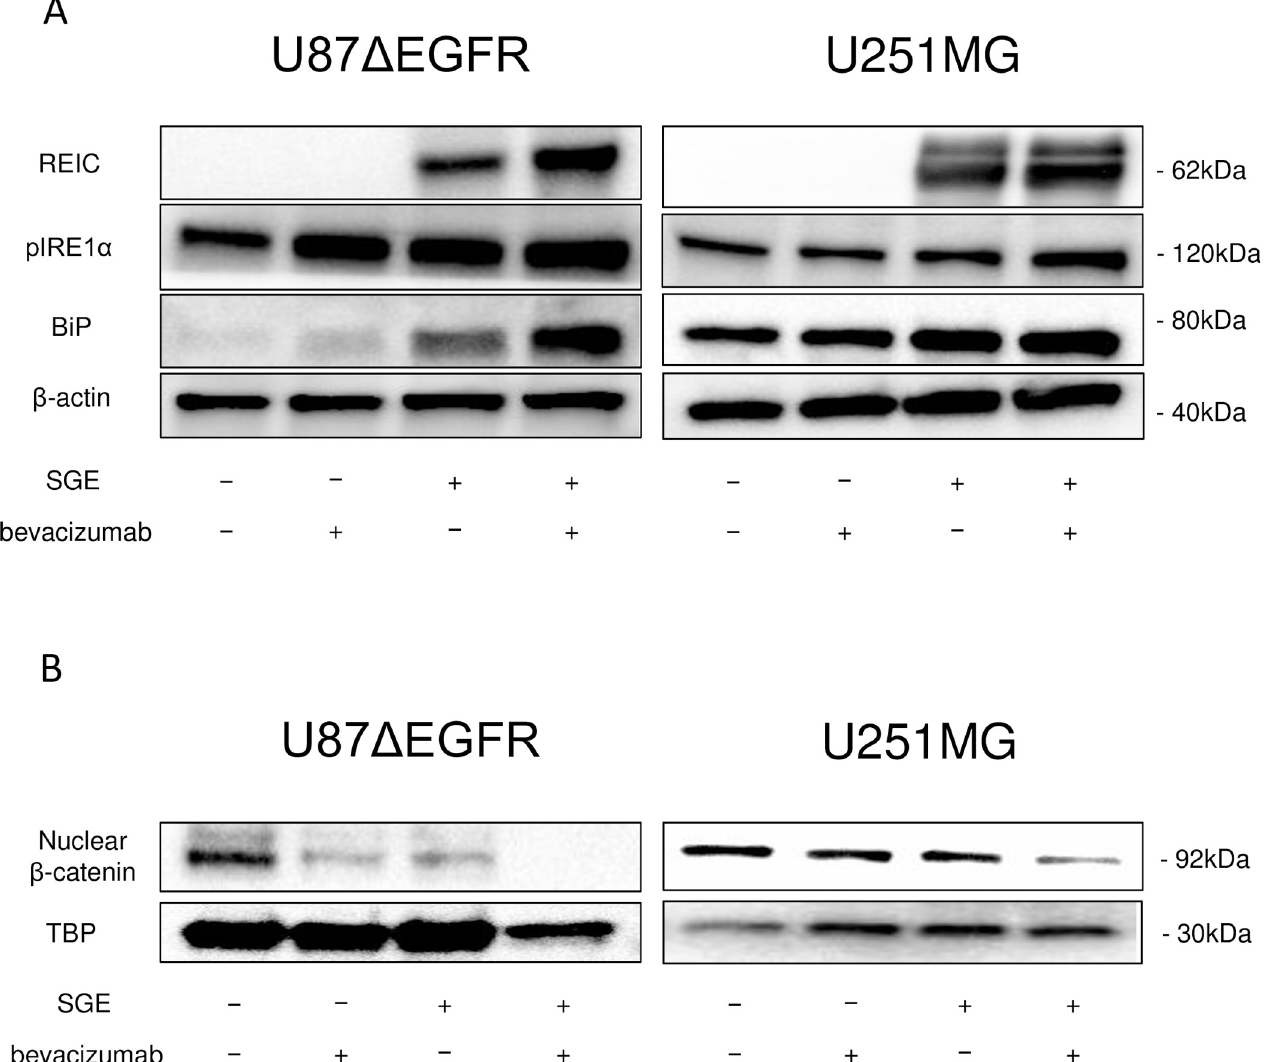
Fig 3. ER stress in U87 Δ EGFR glioma cells after treatment with Ad-SGE-REIC. (A) U87 Δ EGFR or U251MG cells were infected with Ad-SGE-REIC at a MOI of 10. Immunoblot analysis showed that levels of REIC, BiP, and phosphorylated IRE1 α were increased following treatment with